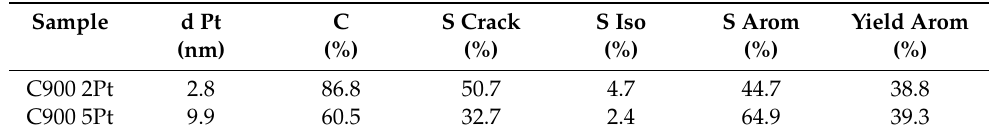
Table 2. Influence of the Pt content on the catalytic performance of supported catalysts pretreated at 600 °C. Conversion and products distribution obtained at 475 °C.